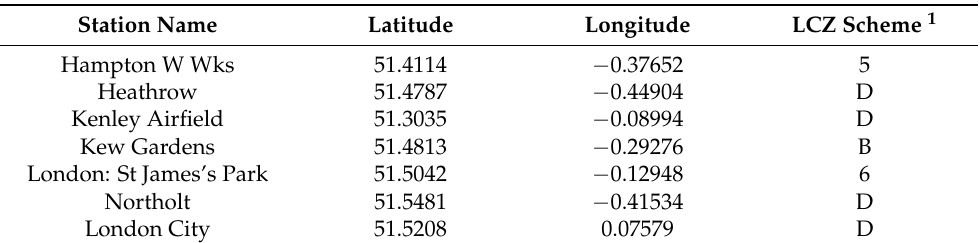
Table 2. Station name, coordinates and local climate zone (LCZ) classification of each Met Office op- erated reference station used in this study. Data from these stations were compared to crowdsourced data in order to test the validity of crowdsourced data.